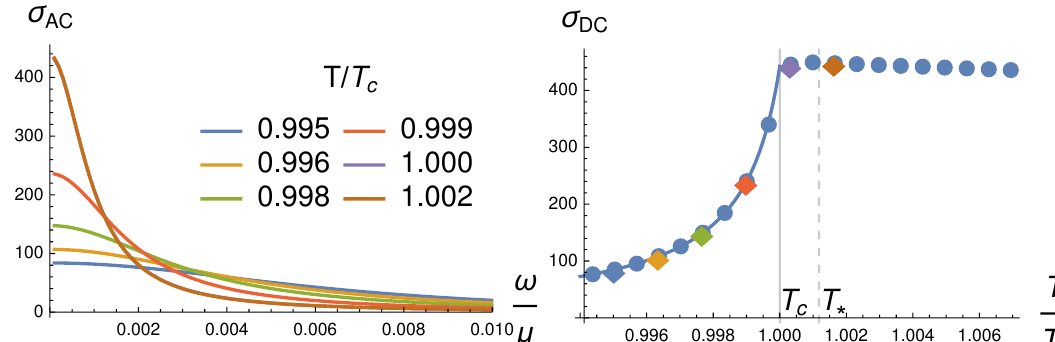
Figure 6. Left panel. AC conductivity across the phase transition in periodic model. The sharp Drude peak above T gets quickly deteriorated below T . c c Right panel. DC conductivity across the phase transition. The blue dots correspond to the DC conductivity obtained directly from near horizon data [61]. The colored diamonds correspond to the zero frequency asymptotes of the AC conductivity curves from the left panel. Blue line is a fit with (4.5). The gridline shows a pole of the fit, which is located above T . c